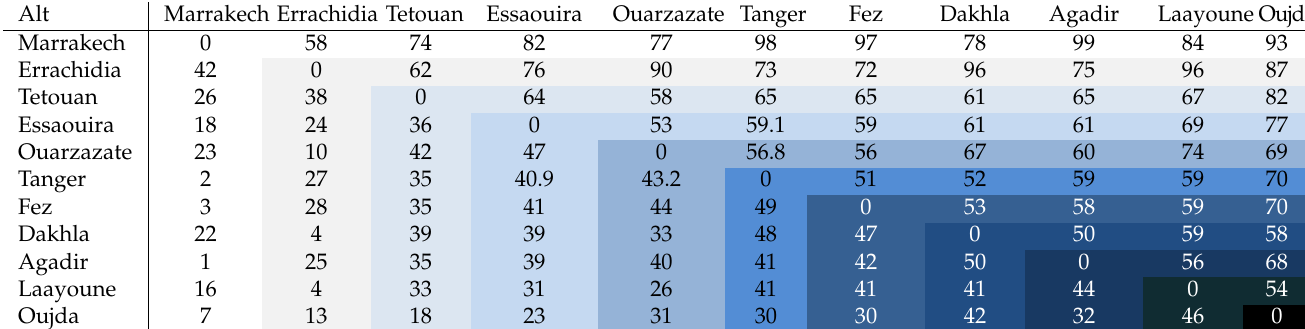
Table 6. Pairwise winning indices c ik for alternatives after third analysis. Complete ranking is formed based on c ik > 50%.